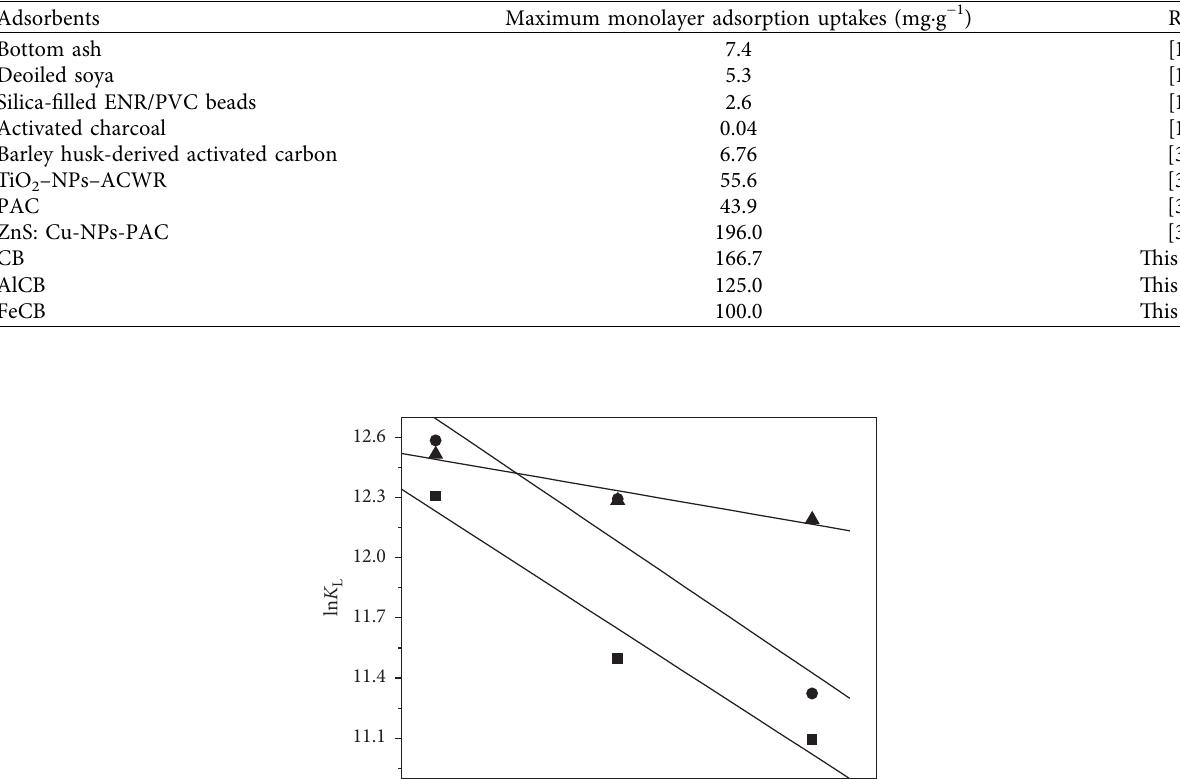
Table 4: Comparison of the adsorption capacity for various adsorbents in phenol red removal that confirm their applicability and suggest their attractive candidates for dye removal.